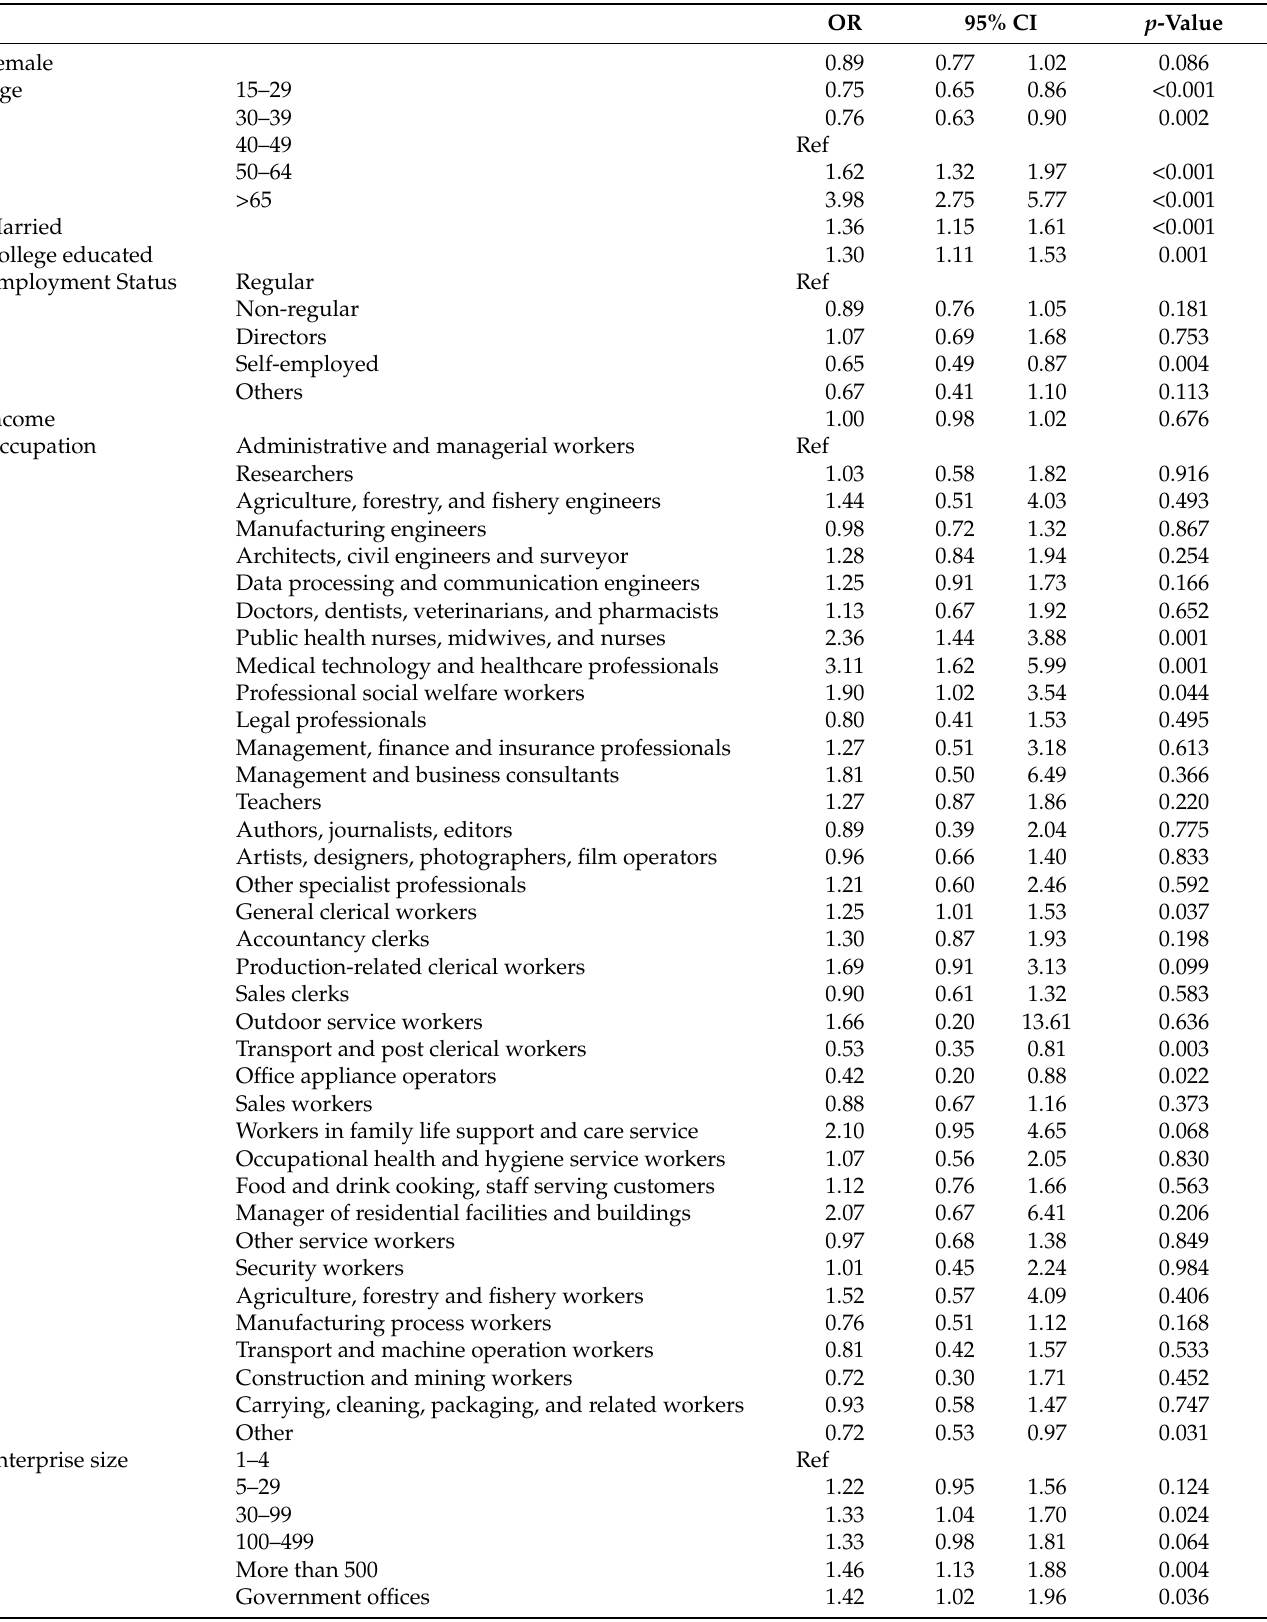
Table 3. Basic Estimation